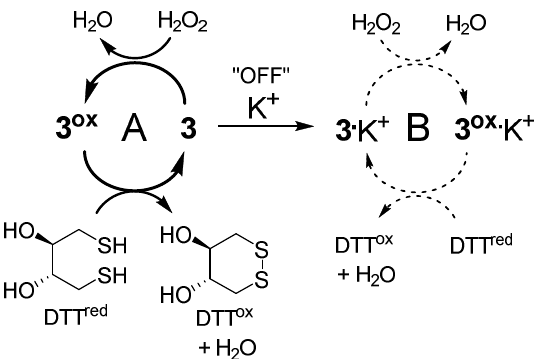
Figure 6. Regulation of the redox catalytic activity of DHS-crown-6 ( 3 ) by the addition of K + in the GPx model reaction between H 2 O 2 and DTT red . Cycle A proceeds rapidly, while Cycle B proceeds slowly because of the conformational transition of 3 induced by coordination to K + .